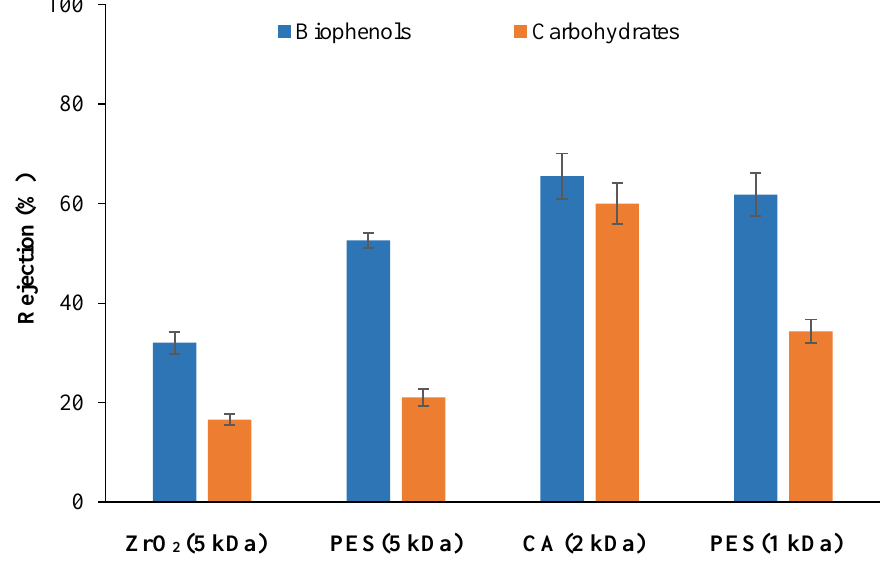
Figure 8. Rejection of tested membranes towards biophenols and